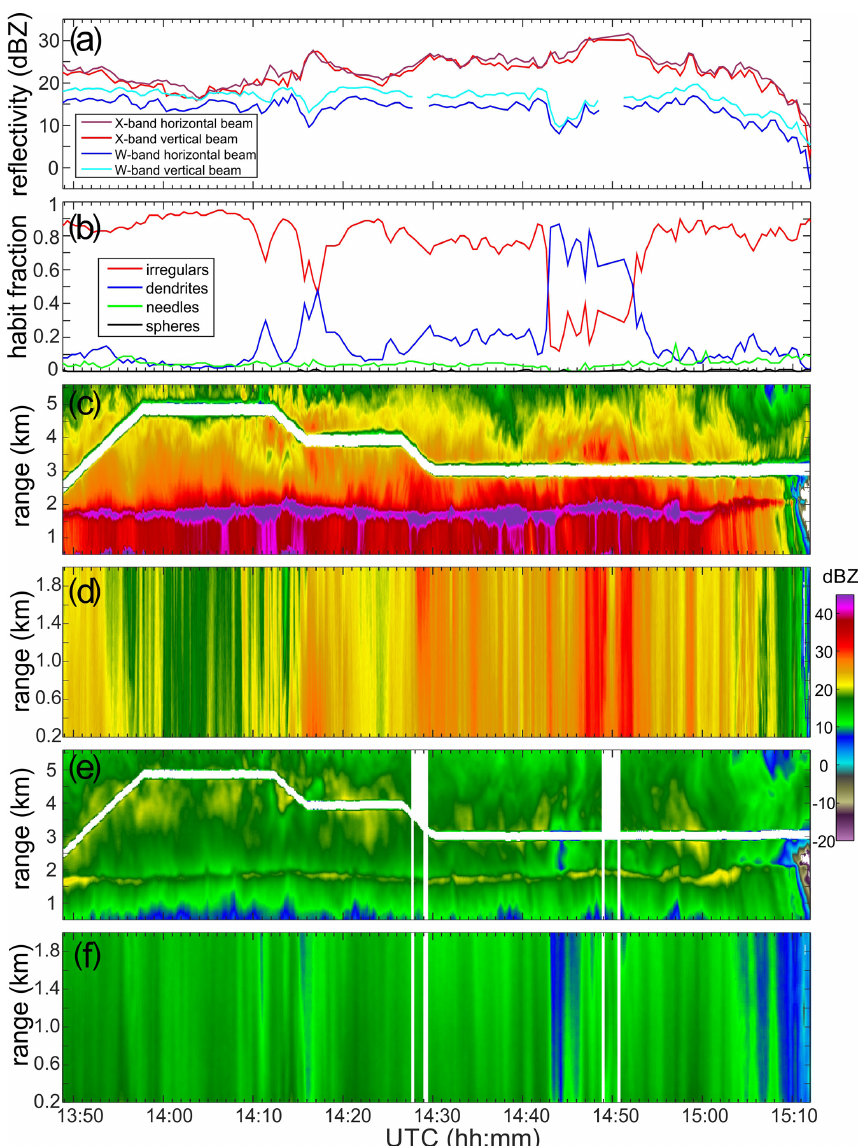
Figure 2. F20 (a) time series of horizontal and vertical beam pointing measurements of NAWX reflectivities at a 250m range gate, (b) esti- mates of relative fractions of different ice hydrometeor habits, (c,d) X-band reflectivity time–height cross sections for vertical and horizontal beam pointing, and (e,f) W-band reflectivity time–height cross sections for vertical and horizontal beam pointing, respectively. Vertical white bands in (e) and (f) indicate no W-band